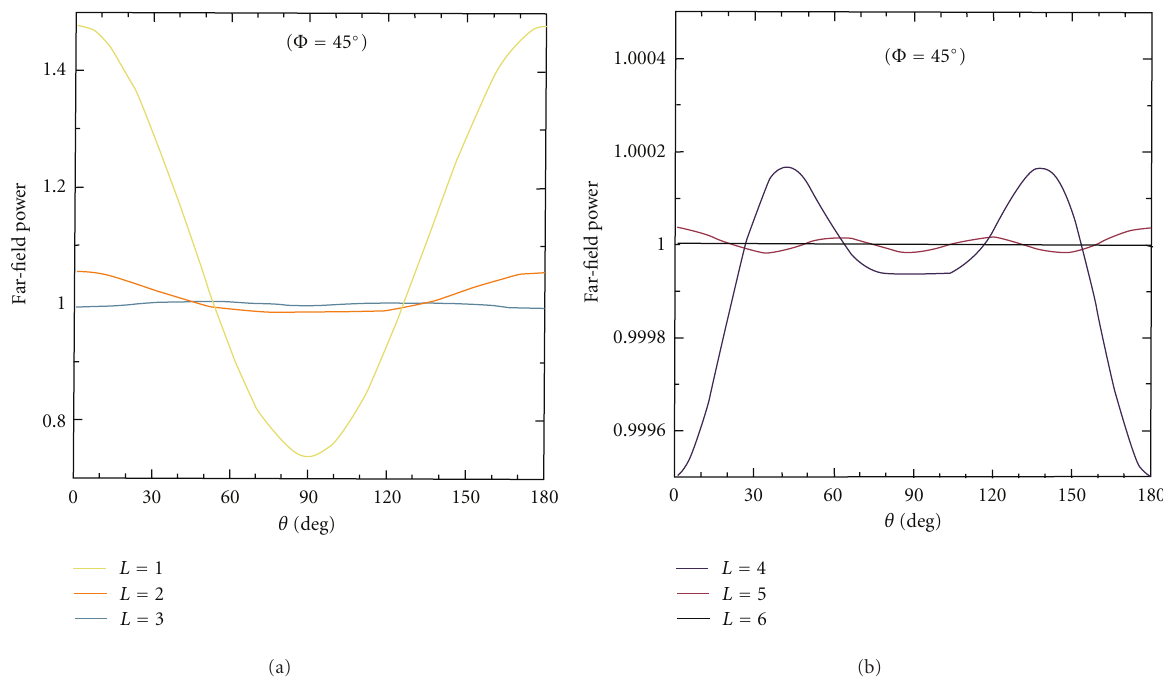
Figure 9: Convergence of the multipole expansion of the far-field power for the isotropic spherical radiator. It is shown in two scales: in a coarse scale (a) and in a fine scale (b), for 0 < θ < π and ϕ = π/ 4. It is shown that 6 multipole terms are enough for excellent convergence of the far-field